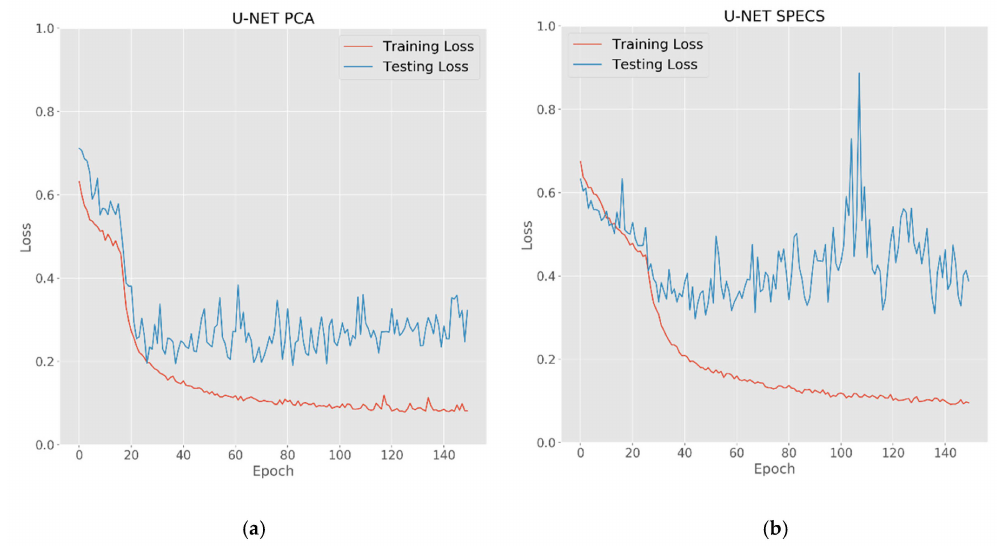
Figure 3. U-NET training (orange) and testing (blue) loss per epoch for both U-NET configurations, showing U-NET PCA ( a ) and U-NET SPECS ( b ).